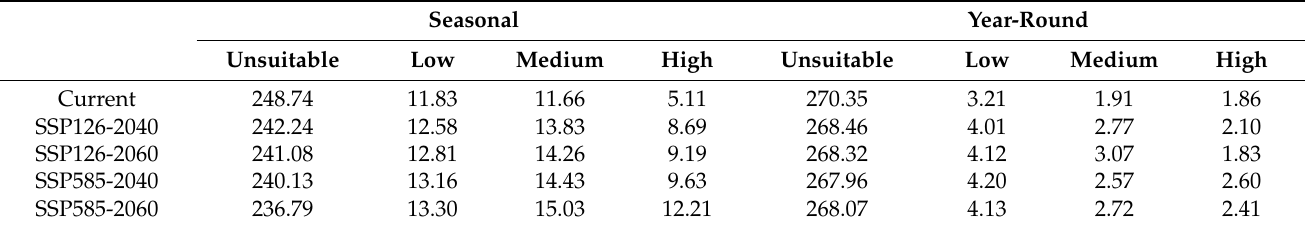
Table 3. Portions of different classes of potential distribution area for seasonal and year-round occurrence under current and four future climate scenarios/years ( × 10 6 km 2